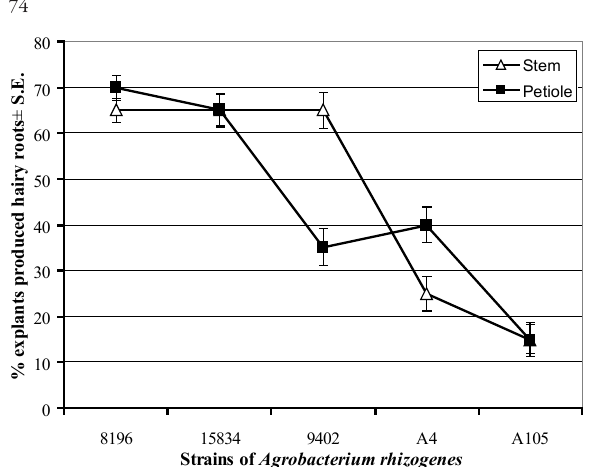
Fig. 2. Strain-dependent variation in hairy root induction on muskmelon explants at 39.3 μmol m -2 s -1